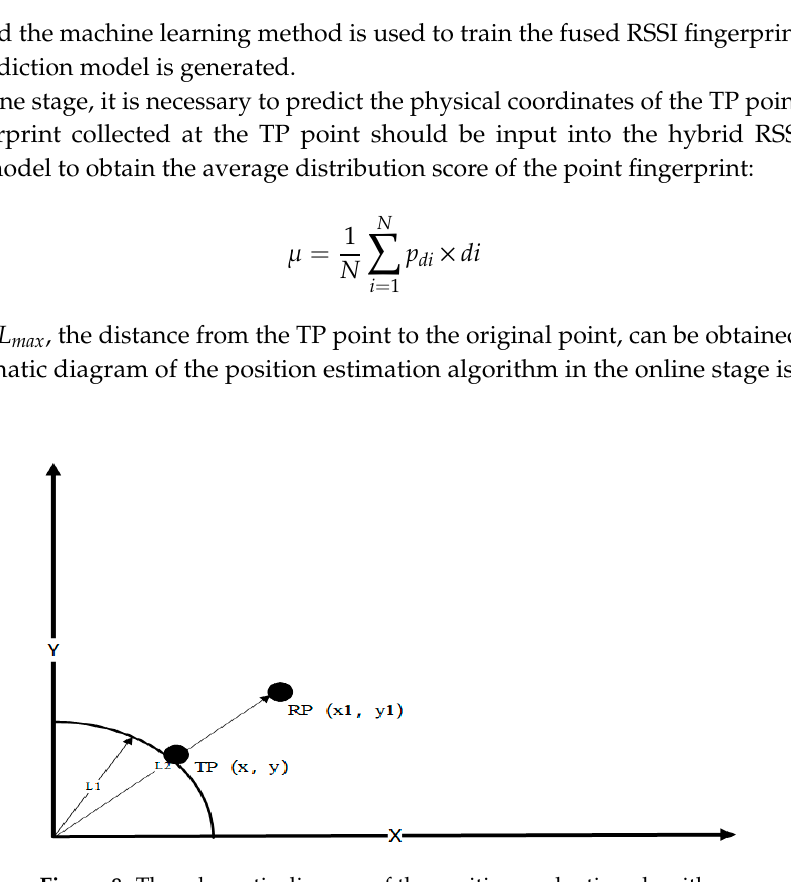
Figure 8. The schematic diagram of the position evaluation algorithm.